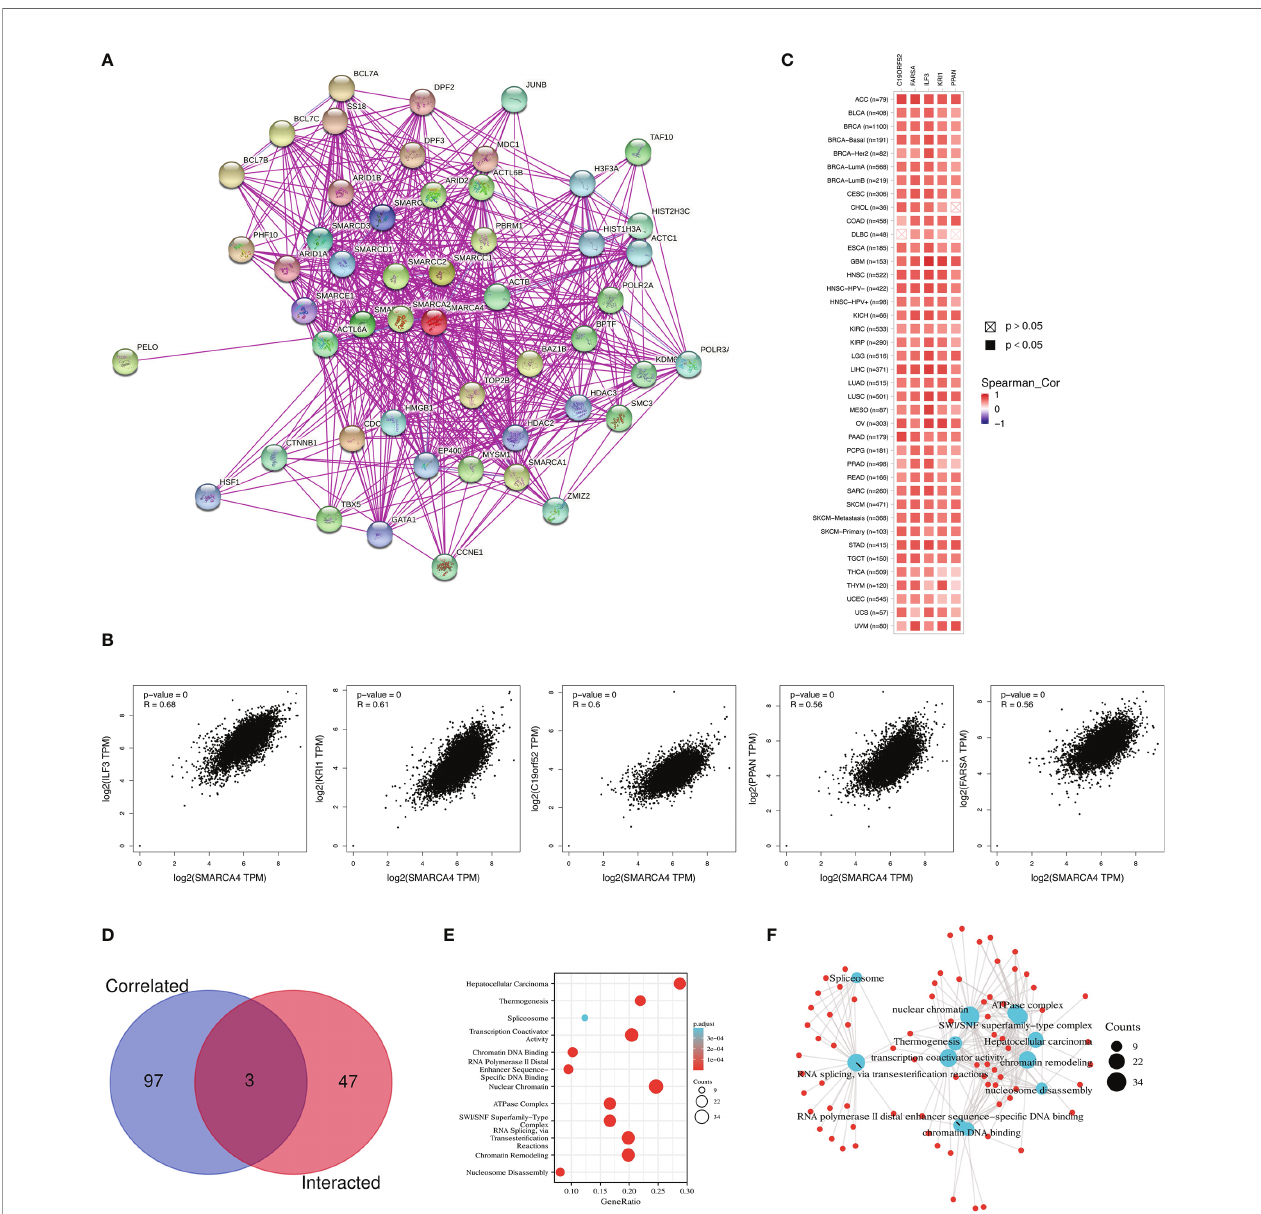
FIGURE 9 | SMARCA4-related gene enrichment analysis. (A) The available experimentally determined SMARCA4-binding proteins using the STRING tool were obtained. (B) The top 100 SMARCA4-correlated genes in TCGA were generated using GEPIA2, and the expression correlation between SMARCA4 and selected targeting genes were analyzed. (C) Heatmap data in the detailed cancer types are displayed. (D) An intersection analysis of the SMARCA4-binding and correlated genes was conducted. (E) KEGG pathway analysis based on the SMARCA4-binding and interacted genes. (F) The cnetplot for the molecular function data in GO